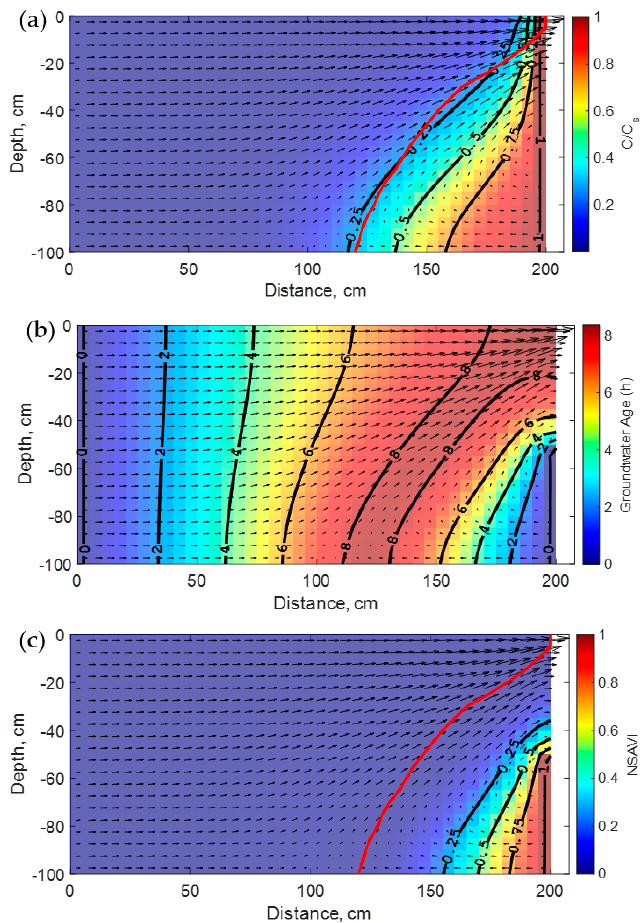
Figure 2. Spatial distribution patterns of ( a ) the steady-state concentration isochlors, ( b ) the direct mean groundwater age, and ( c ) the vulnerability index to seawater intrusion for the standard Henry problem. The zero-vulnerability line (ZVL) is plotted with red color.